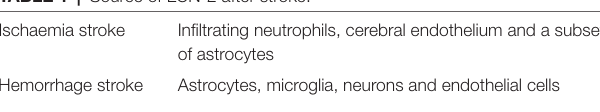
TABLE 1 | Source of LCN-2 after